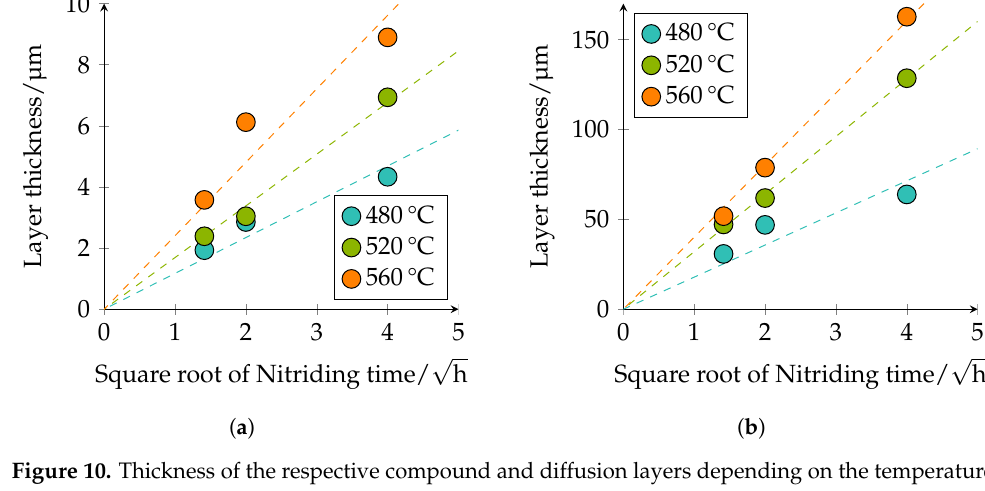
Figure 10. Thickness of the respective compound and diffusion layers depending on the temperature versus the square root of the plasma nitriding time. The linear regressions without onset are added to clarify the relationship of the layer thickness as a function of the root-time law. ( a ) Thickness of the compound layer (CL). ( b ) Thickness of the diffusion layer